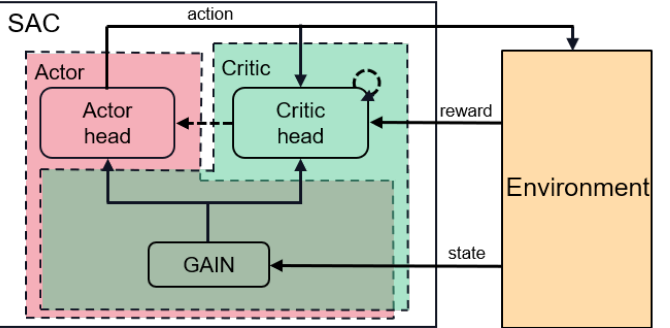
Figure 1. Architecture of FIRTAD. FIRTAD, which is based on a deep reinforcement learning frame- work, consists of two parts, the agent and the environment. The agent is implemented by an SAC algorithm, in which the Actor and the Critic share the same feature interaction module GAIN as their deep modules. The environment is implemented with a sampling function and a reward